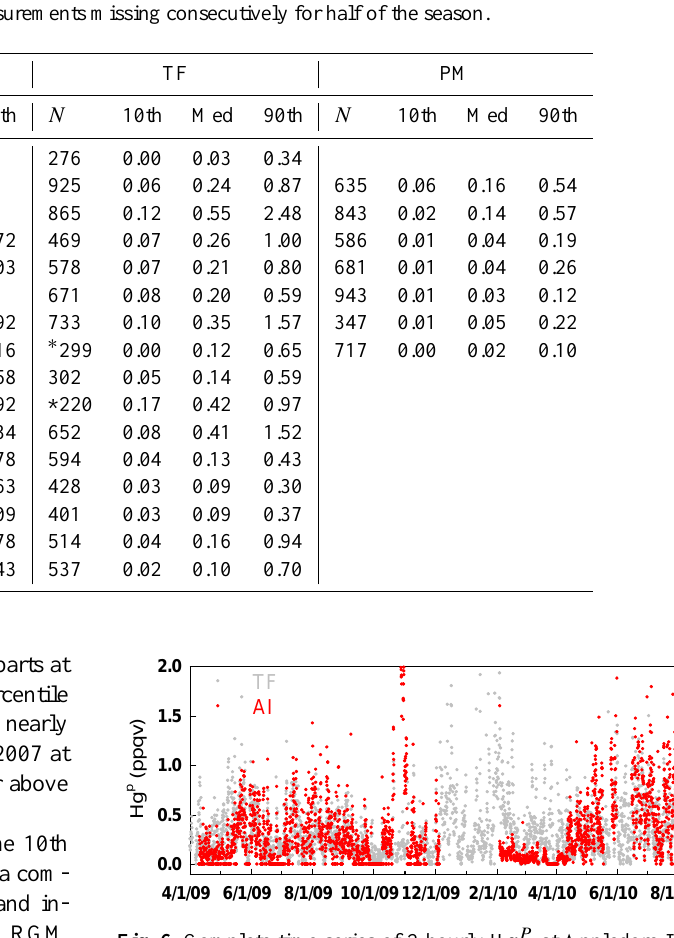
Figure 6. Complete time series of 2-hourly Hg P at Appledore Island (AI) and Fig. 6. Complete time series of 2-hourly Hg P at Appledore Island Thompson Farm (TF). (AI) and Thompson Farm